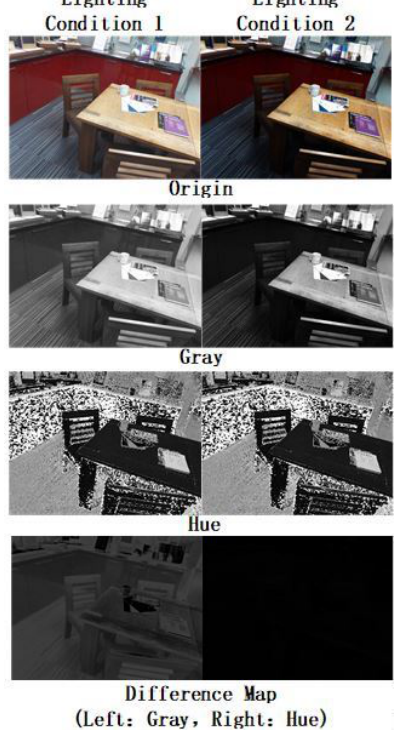
Figure 1. The comparison of the same scene at different lighting